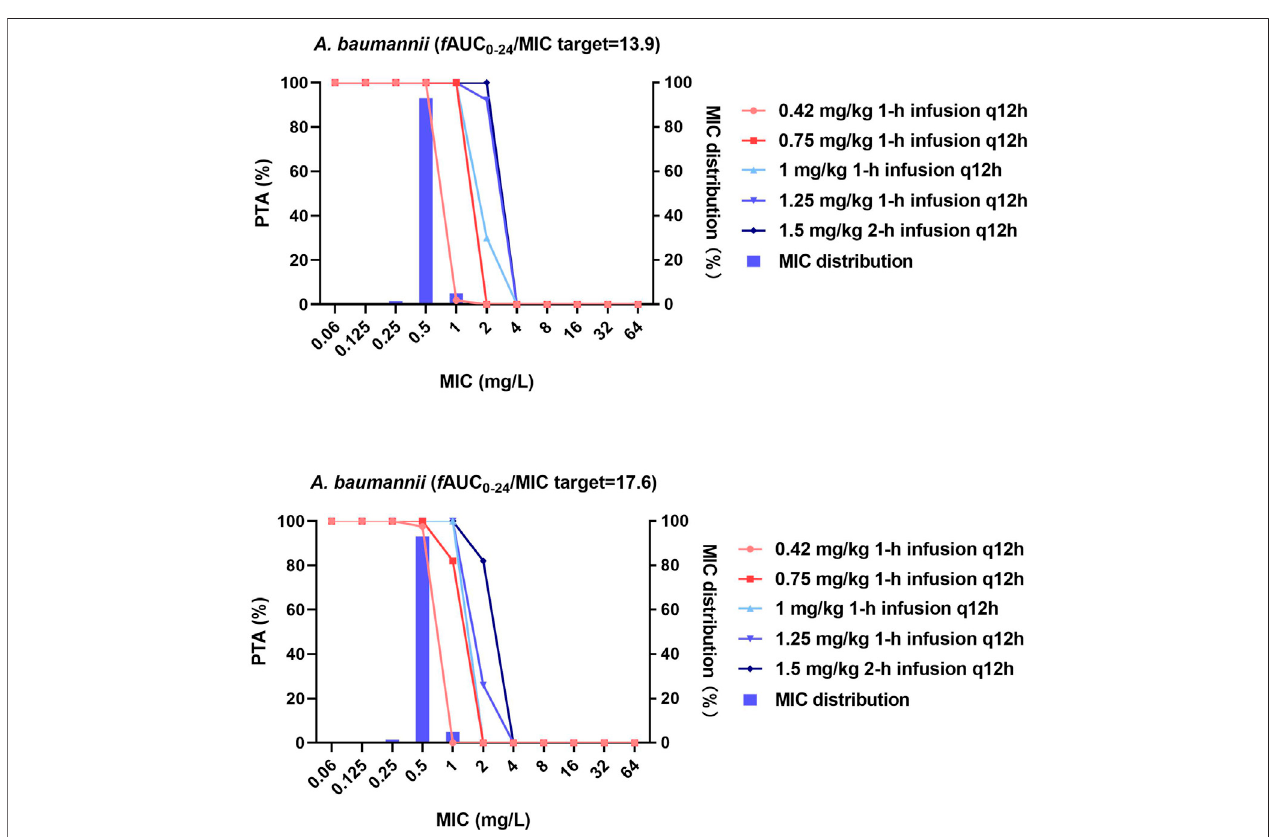
FIGURE 2 | MIC distribution and PTA of different dosing regimens against A. baumannii . MICs of > 32 mg/L are represented by 64 mg/L; PTA was determined using the AUC